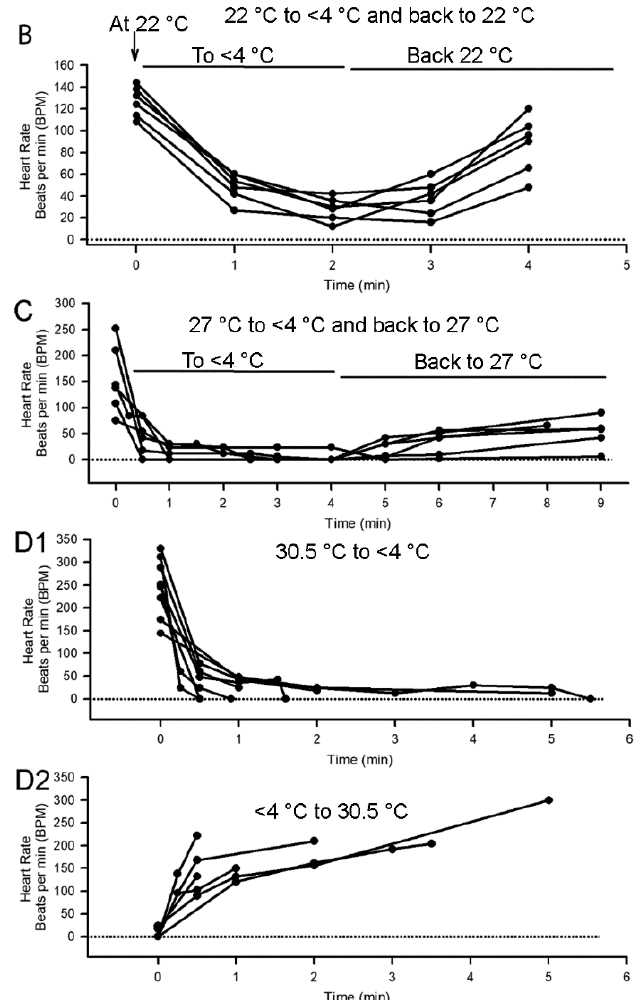
Figure 4. The effect of cold on heart rate for crabs, crayfish and shrimp. ( A ) Crabs decreased their heart rate upon being submerged over a 5 min period in a sea ice slurry (<4 °C). Their rates